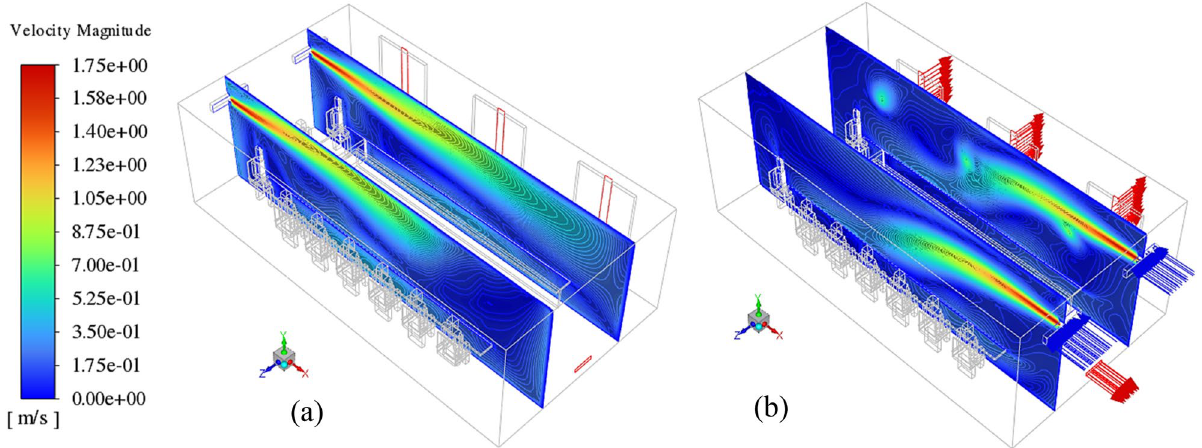
Figure 9. Airflow velocity contour at z = 2.3 and 4.7 m, and effects of the air supply location: ( a ) mode 2, and ( b ) mode 3, (blue and red arrow indicators point to input and output airflow,